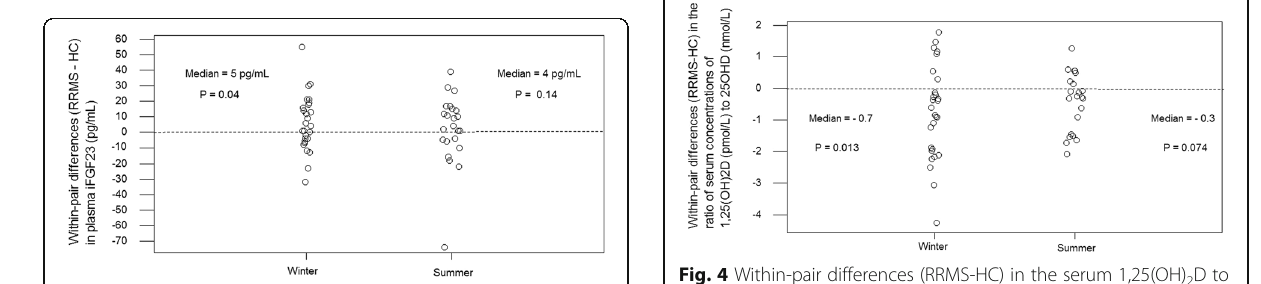
Fig. 3 Within-pair differences (RRMS-HC) in plasma iFGF23